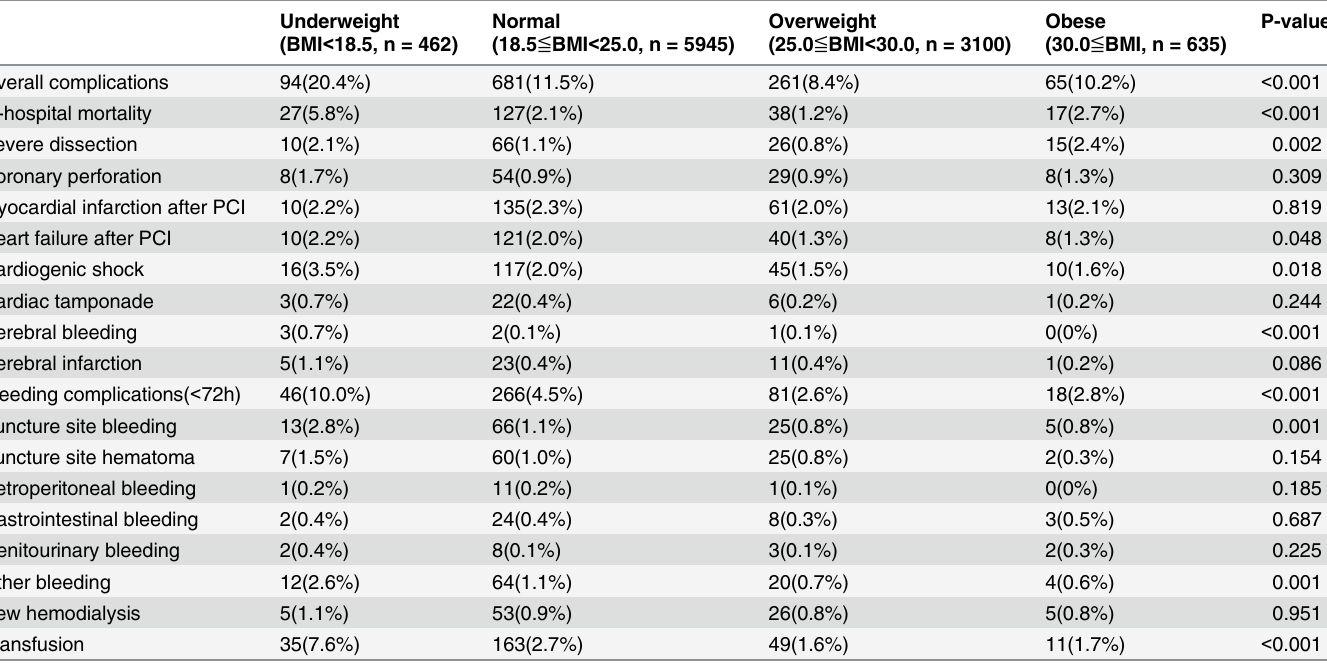
Table 3. Complications.